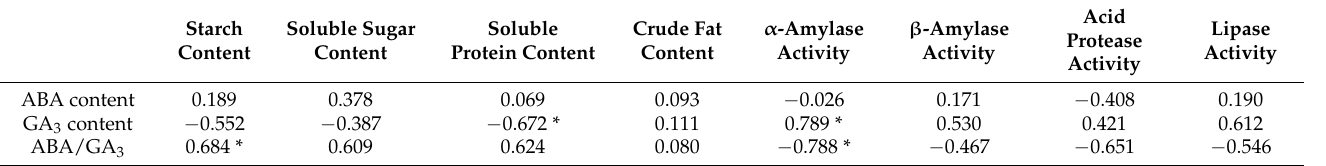
Table 1. Pearson correlation coefficients of hormones and nutrients at each stage during cold strat- ification.